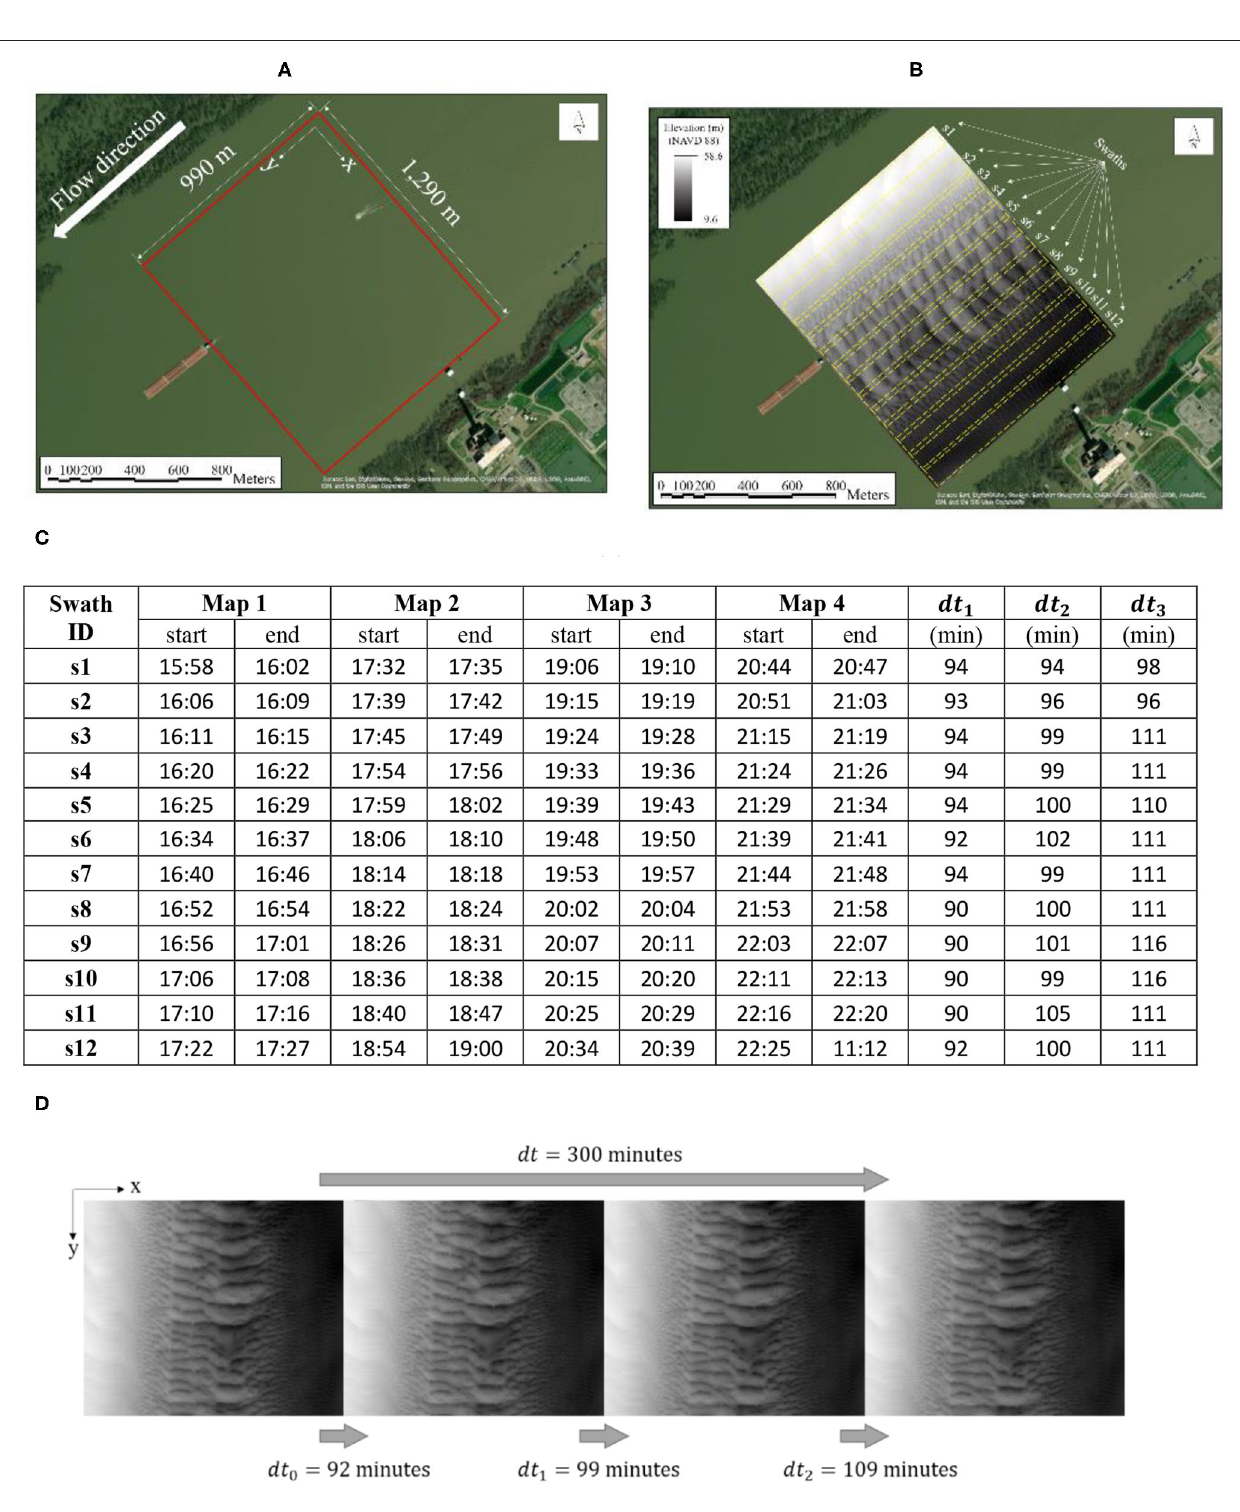
Frontiers in Water |